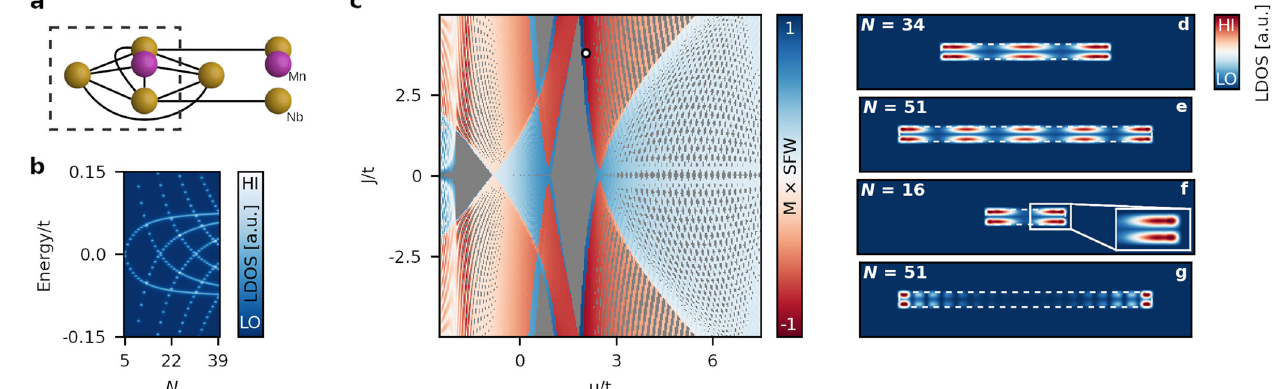
Fig. 3 Properties of simpli fi ed model for Majorana modes with side features. a De fi nition of unit cell and hoppings of the simpli fi ed model. b Evolution of the side features with chain length N in analogy to the experimental Fig. 4b. Parameters: ( Δ , α , μ , J ) = (0.05, 0.01, 2.05, 3.4) t . c Representative topological phase diagram for Δ = 0.05 t , α = 0.01 t and N = 51. Topologically non-trivial (trivial) regions are shown in red (blue), and are multiplied with the side feature weight (SFW) which quanti fi es how much spectral weight is accumulated on the side-Nb atoms (see Supplementary Note 3.B for details). Gray regions correspond to lowest energy states with E > 0.04 t , which are thus not of interest. The white dot marks the parametric location of Fig. 1e. d Real-space zero-energy LDOS( x , y ) with side features revealing a periodic pattern reminiscent of a Mn 34 chain on Nb(110) 20 . Parameters: ( Δ , α , μ , J ) = (0.05, 0.01, 2.05, 3.4) t . e Real-space zero-energy LDOS( x , y ) with side features revealing a periodic pattern reminiscent of a Mn 51 and Mn 52 chains on Nb(110), c.f . Fig. 4a. Parameters: ( Δ , α , μ , J ) = (0.05, 0.01, 2.05, 3.8) t . f Real- space zero-energy LDOS( x , y ) with side features with reduced periodic pattern in the bulk reminiscent of a Fe 16 chain on Nb(110), c.f . Fig. 4c. Parameters: ( Δ , α , μ , J ) = (0.1, 0.05, 2, 4.9) t . g Real-space zero-energy LDOS( x , y ) with side feature only at the chain ends, reminiscent of the observed double-eye feature for Fe chains on Pb(110) 24 . Parameters: ( Δ , α , μ , J ) = (0.15, 0.1, 1.35, 6) t . The zero-energy LDOS states shown in d – g are in the topological